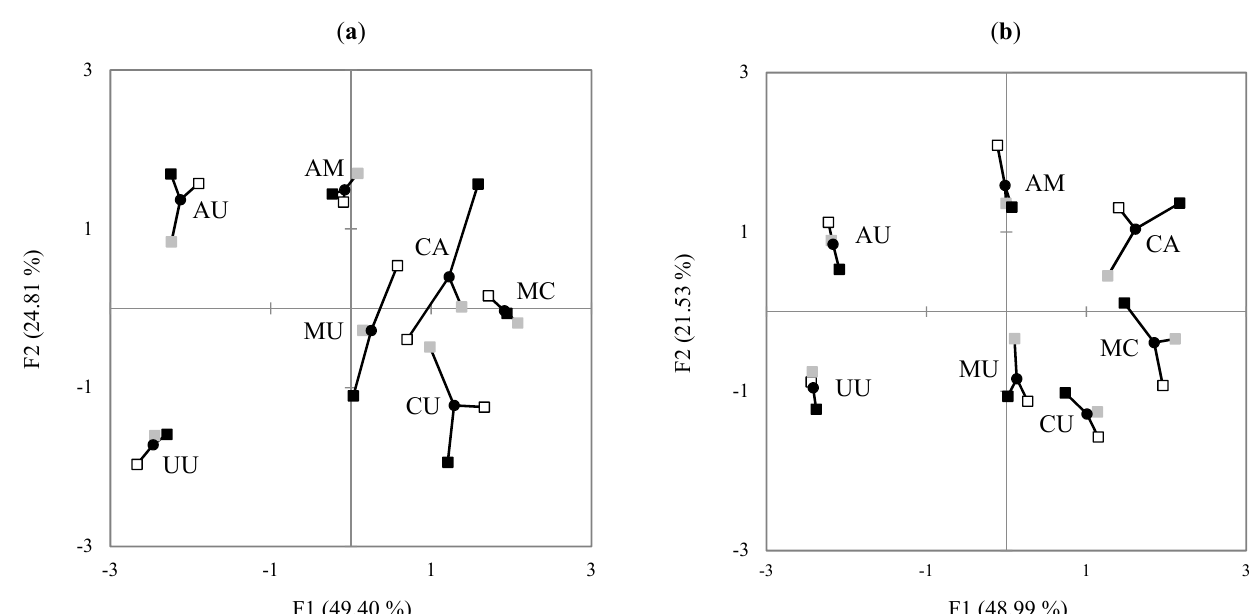
Figure 4. Superimposed representation of the samples ( ● ) from multiple factor analysis (MFA): ( a ) IL, ; IM, ; IH, , ( b ) NL, ; NM, ; NH, . See Table 1 for sample codes.